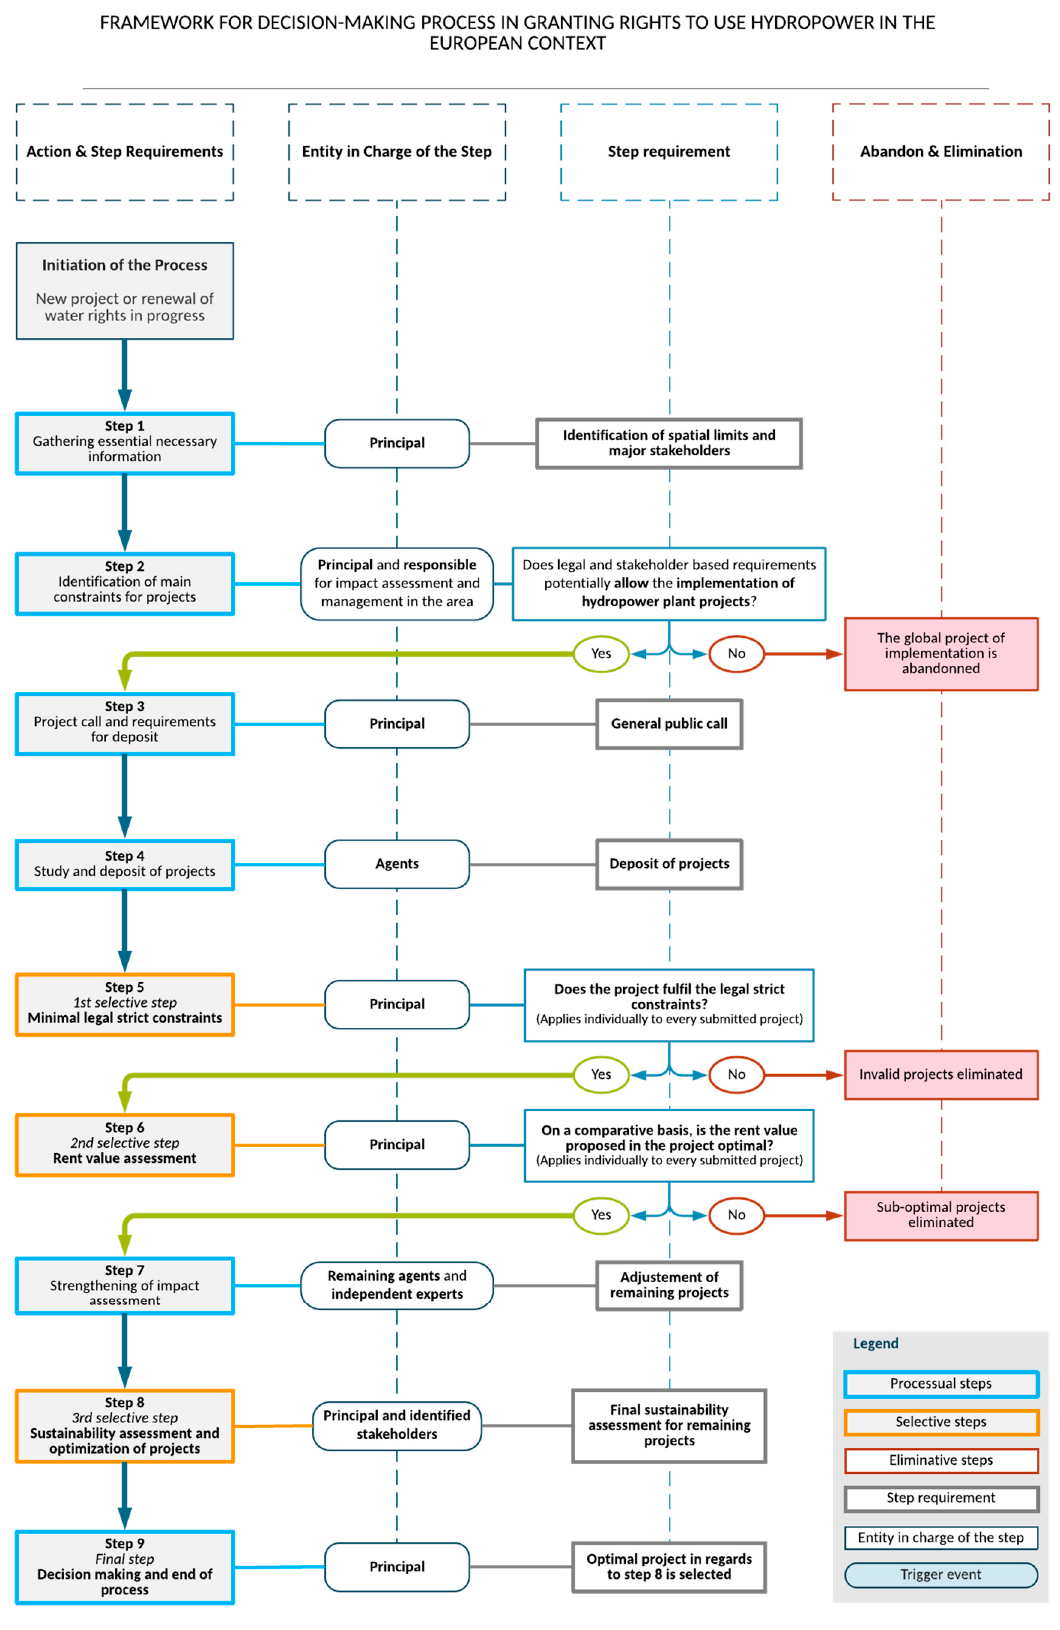
Figure 1. Framework for decision making process in granting rights to use hydropower in the European context.